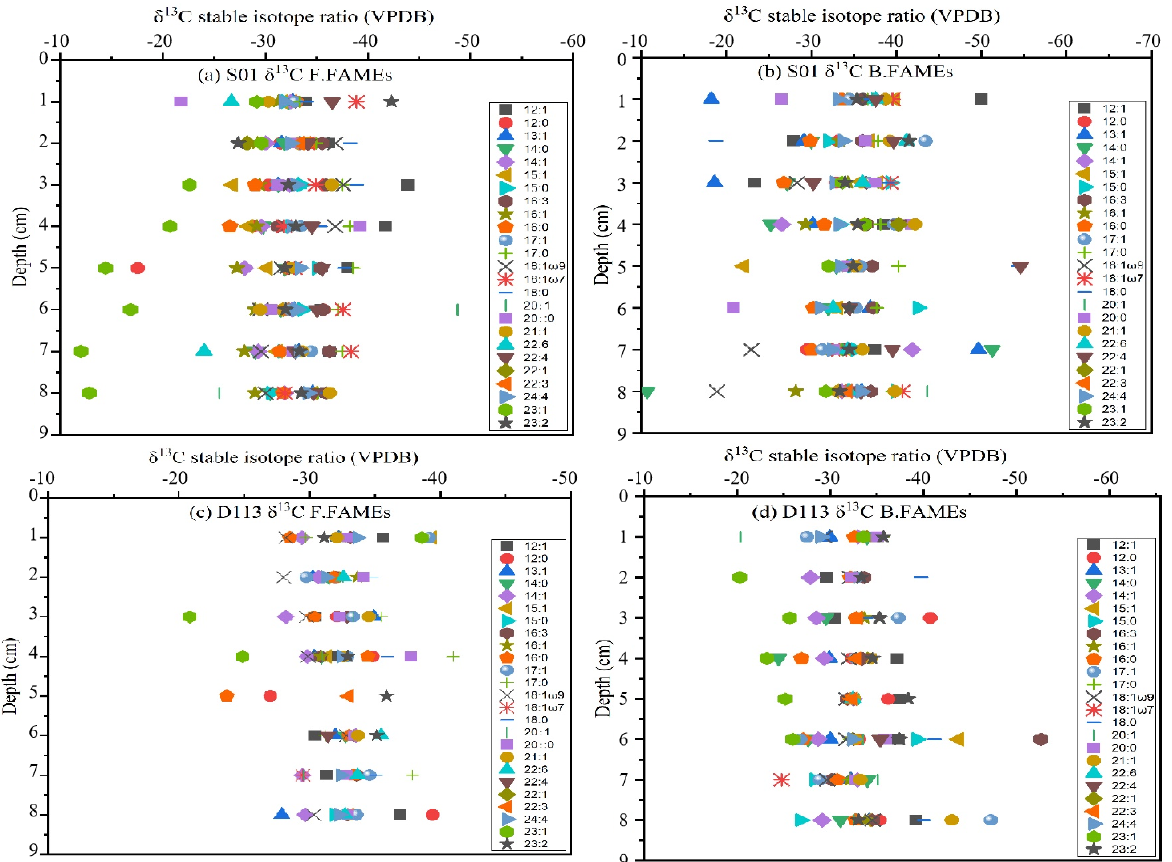
Figure 7. The δ 13 C values of FAs from sediment samples of the north Yap Trench. Panels ( a , b ) represent the δ 13 C values of free and bound FAs in the sediment sample from station S01, and panels ( c , d ) represent the δ 13 C values of free and bound FAs in the sediment sample from station D113.